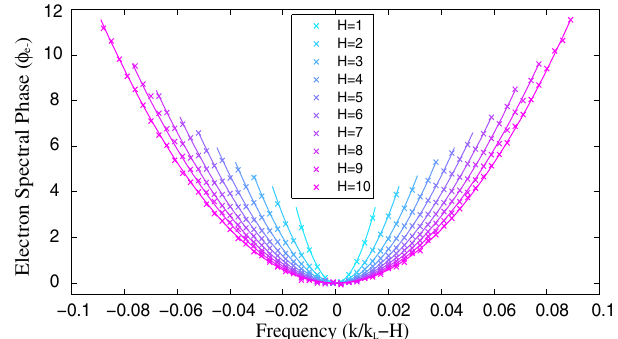
FIG. 4. Spectral phase of the electron bunching factor from Fig. 2 for the first ten harmonics. Solid line calculated from Eq. (12), with crosses taken from simulations. At higher har- monics the curves are wider due to the increasing bandwidth.